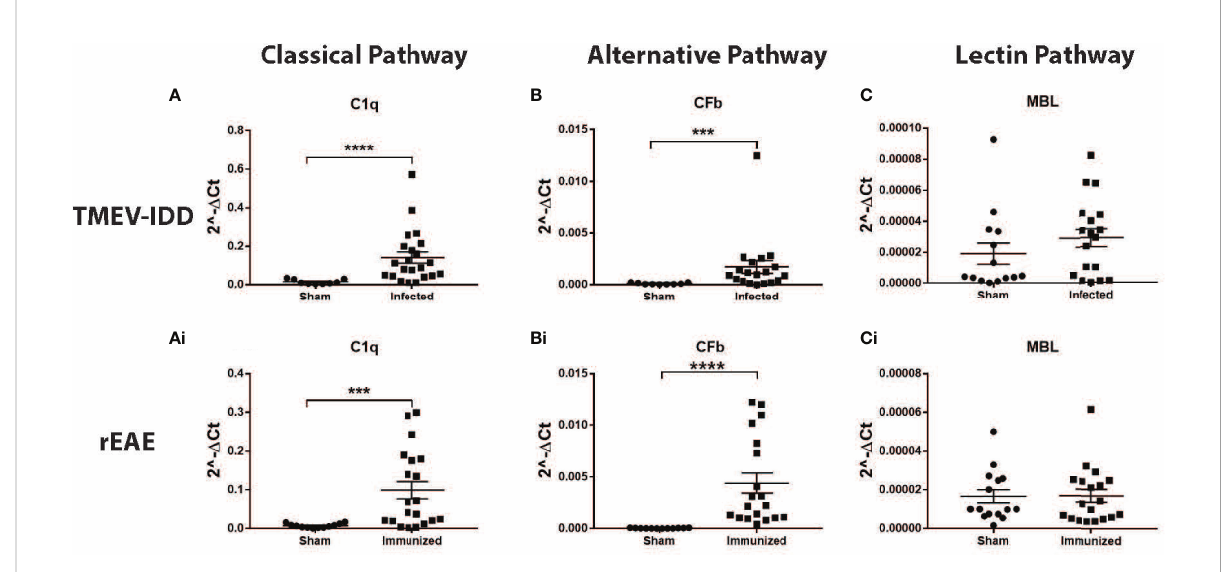
FIGURE 4 CNS gene expression of early complement components activating the three activation pathways of the complement cascade. Gene expression levels of C1q, CFb, and MBL were determined by rt-PCR in the spinal cords from TMEV-IDD mice (n =26) at day ~120 post-infection and rEAE mice (n =20) at day ~15 post-immunization. Age-matched sham controls were tested as reference group (n = 10 and n = 10, respectively). A signi fi cant upregulation of C1q and CFb was observed in TMEV-IDD (A, B) and rEAE (Ai, Bi) mice compared to their respective age-matched sham controls. MBL was not upregulated in either of the two models (C, Ci) . Scatter plots display C1q (A, Ai) , CFb (B, Bi) and MBL (C, Ci) in TMEV-IDD (A – C) or rEAE (Ai, Bi, Ci) mice with mean ± SEM for the group. Expression values are obtained by the D Ct method, where GAPDH is utilized as control gene. Relative expression values (2- D Ct) are plotted on the y-axis. Signi fi cant differences are indicated (***P<0.001 and ****P<0.0001) as determined by Mann-Whitney